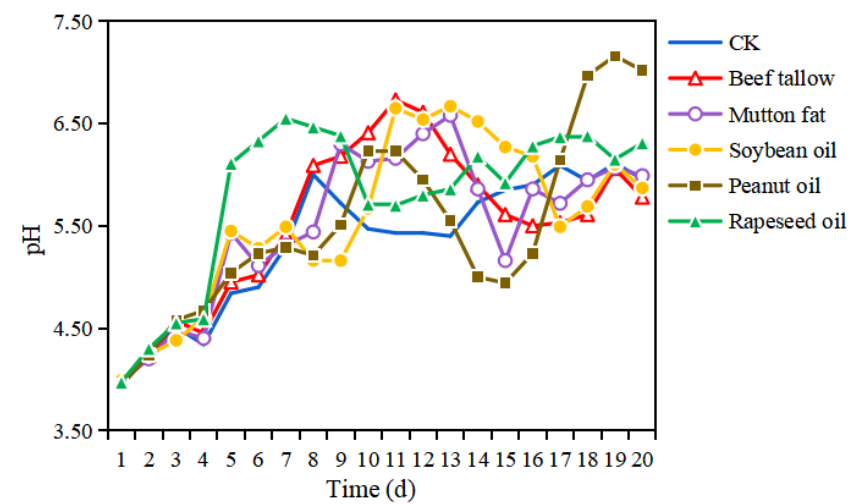
Figure 1. Changes of pH in treatments with different types of lipids.